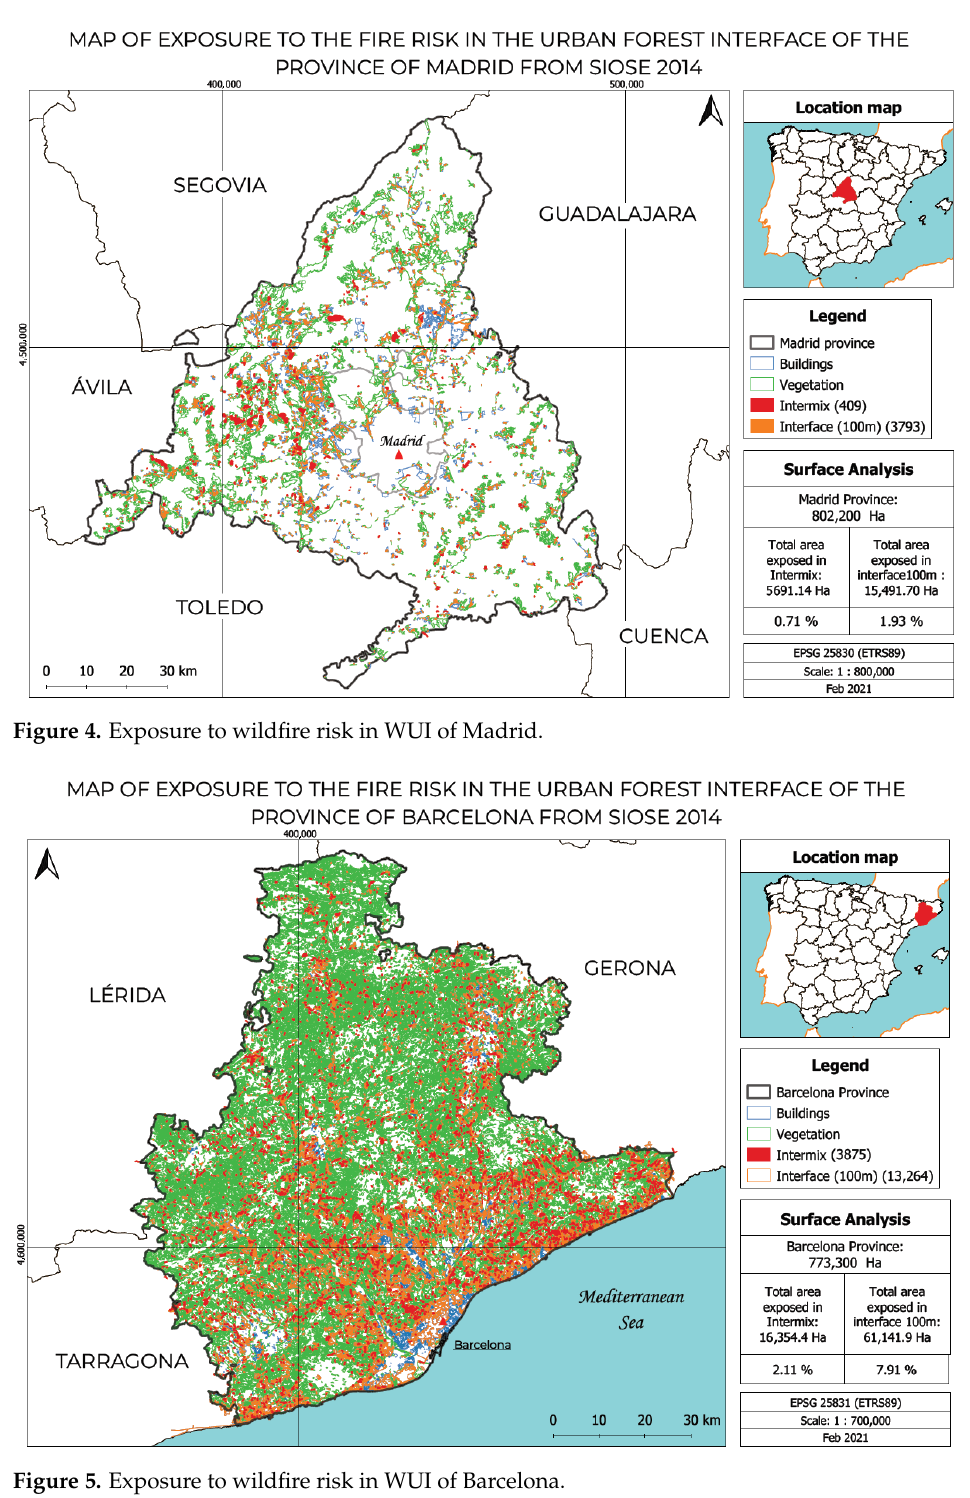
Figure 1. Location map of the metropolitan areas of Madrid and Barcelona and study areas where the methodology was tested in detail.